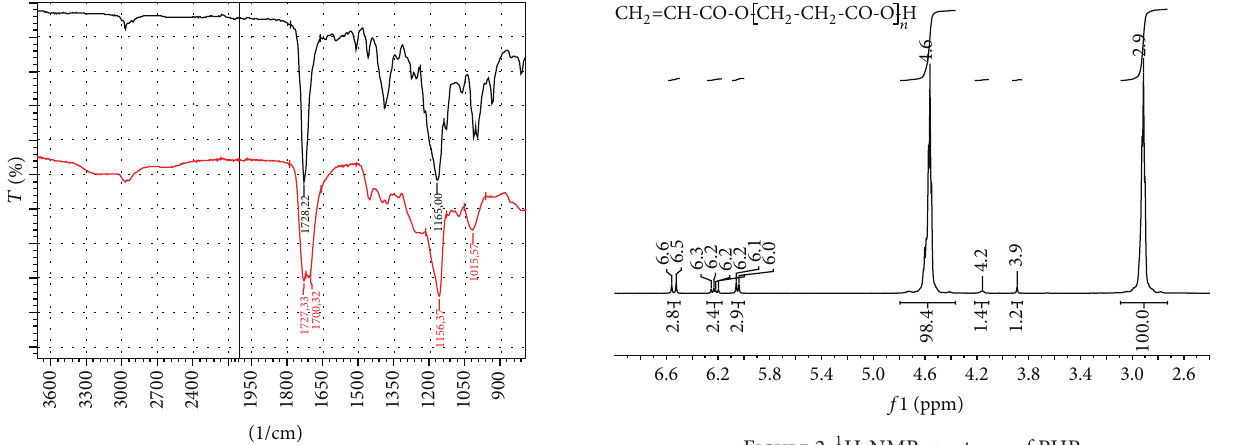
Figure 2: 1 H-NMR spectrum of